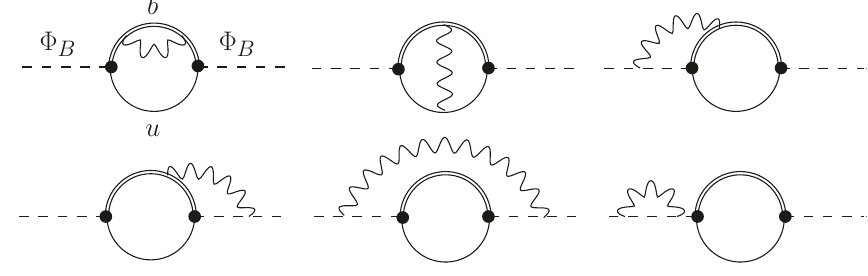
Figure 3 . Diagrams contributing to C ( p 2